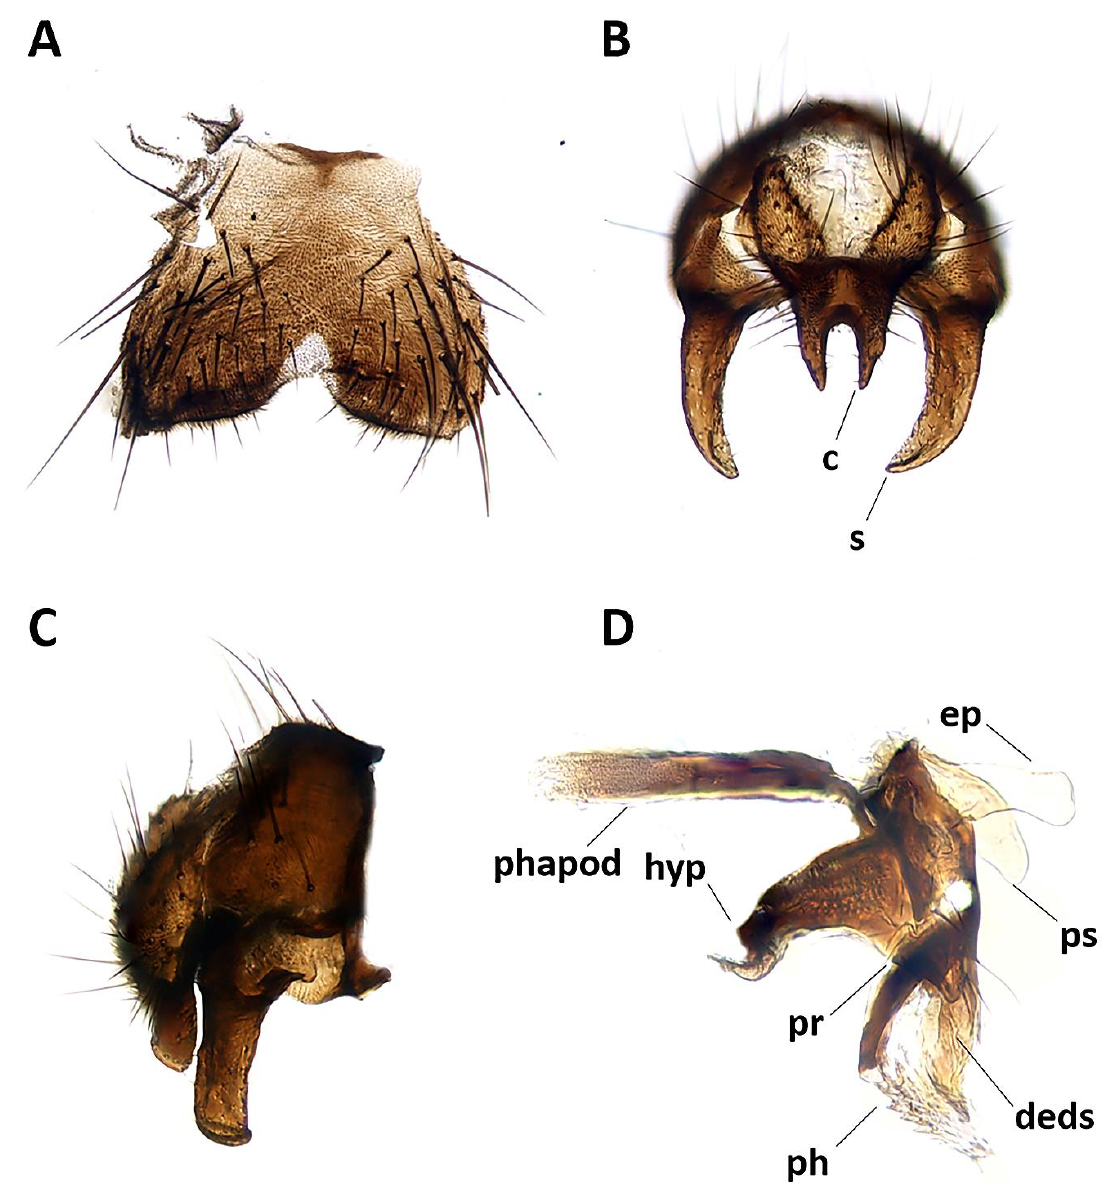
Figure 3. Aporeomyia elaphocera sp. nov. , terminalia (holotype ♂ , CSCA). ( A ) Sternite 5 in ventral view; ( B ) epandrial complex in posterior view, c = cercus, s = surstylus; ( C ) epandrial complex in lateral view; ( D ) hypandrial complex and phallus in lateral view, phapod = phallapodeme, deds = dorsal extension of dorsal sclerite of distiphallus, ep = epiphallus, hyp = hypandrium, ph = phallus, pr = pregonite, ps = postgonite.